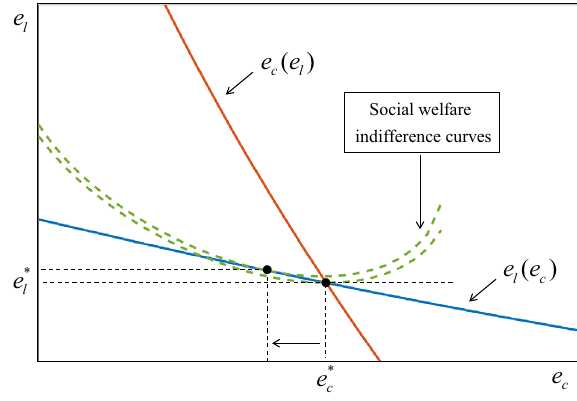
Fig. 10 Limiting the size of the central